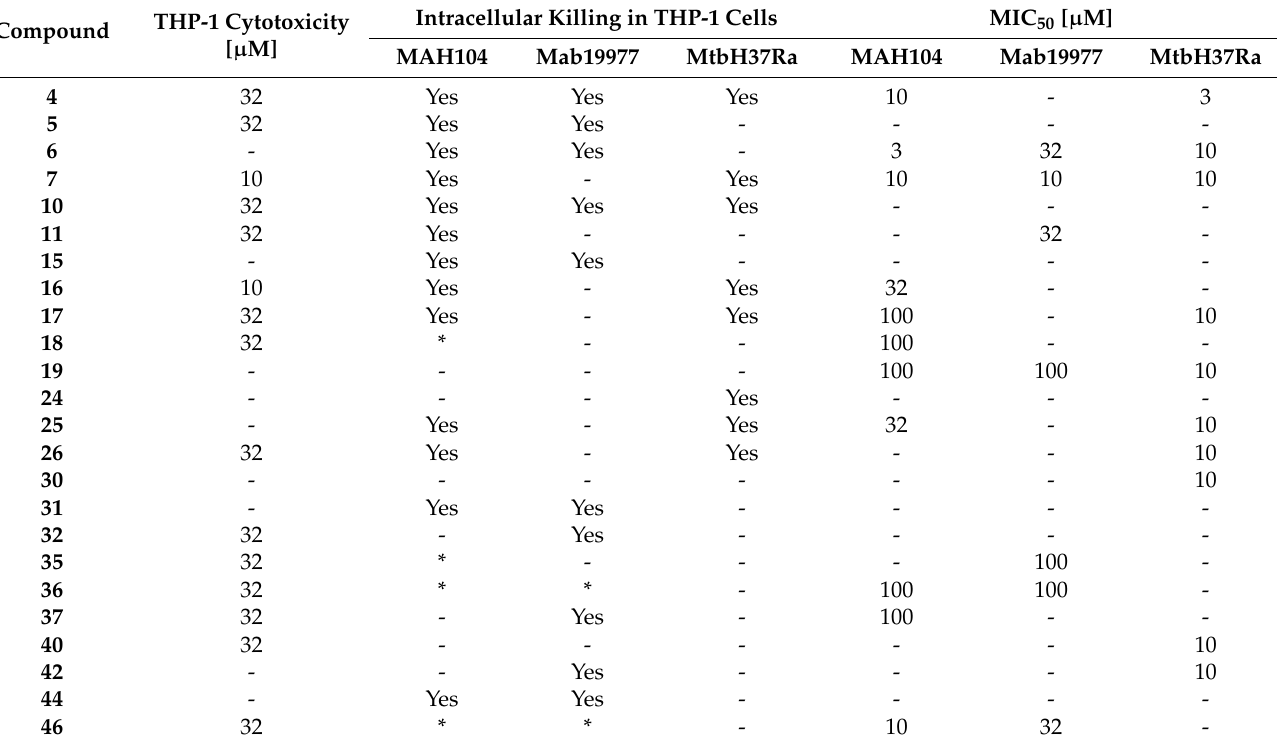
The cytotoxicity of 58 compounds was tested in differentiated THP-1 cells in the con- centration range of 0.1 to 100 μ M using a resazurin colorimetric assay together with the visual examination of macrophage monolayers. Bacterial survival assays were performed at the highest concentration of compounds that were nontoxic to THP-1 cells (Table 2). Table 2. Activity of hit compounds in THP-1 macrophages and in